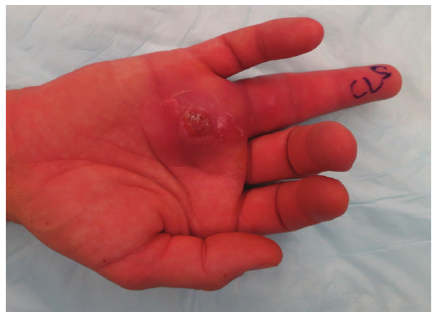
Figure 2: Tenosynovitis of the flexor digitorum superficialis (FDS) and flexor digitorum profundus (FDP) tendons. Clear nonpurulent fluid was noted around the tendons. A small puncture area was explored, and no foreign bodies were seen. Tissue samples were sent for pathology and routine and acid fast bacilli (AFB) cultures. Due to the high concern for a potential mycobacterial infection, clarithromycin, moxifloxacin, and rifabutin were started empiri- cally. Three days later, he discontinued these medications due to gastrointestinal side effects from rifabutin without informing his physicians. Exudative cultures were negative; however, AFB cultures were positive, consistent with Mycobacterium marinum